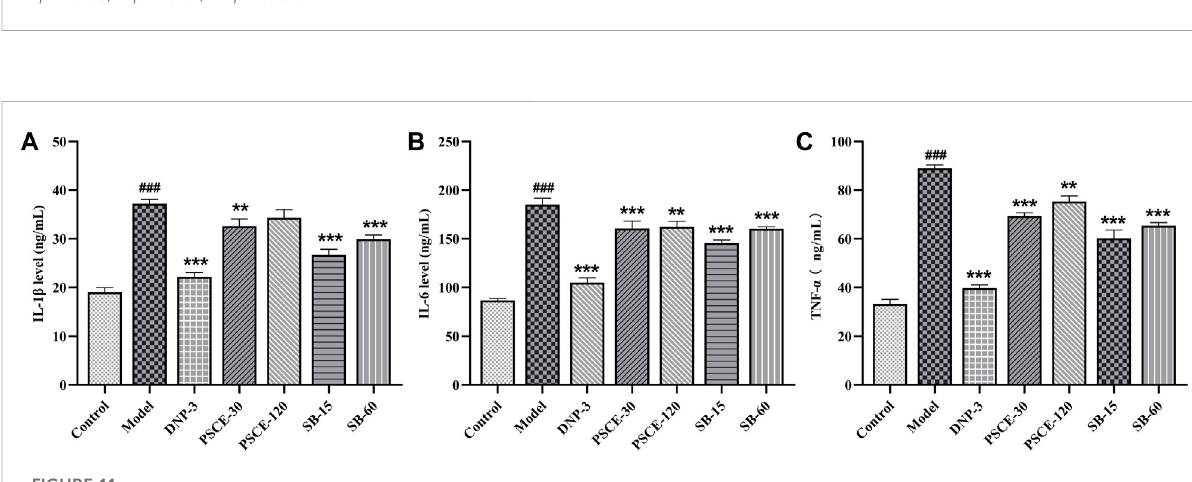
FIGURE 11 Effects of PSCE and SB on scopolamine-induced neuroin fl ammation. (A) serum IL-6 level. (B) serum TNF- α level. (C) serum IL-1 β level. Compared with control group, ### p < 0.05; Compared with model group, ** p < 0.01, *** p <